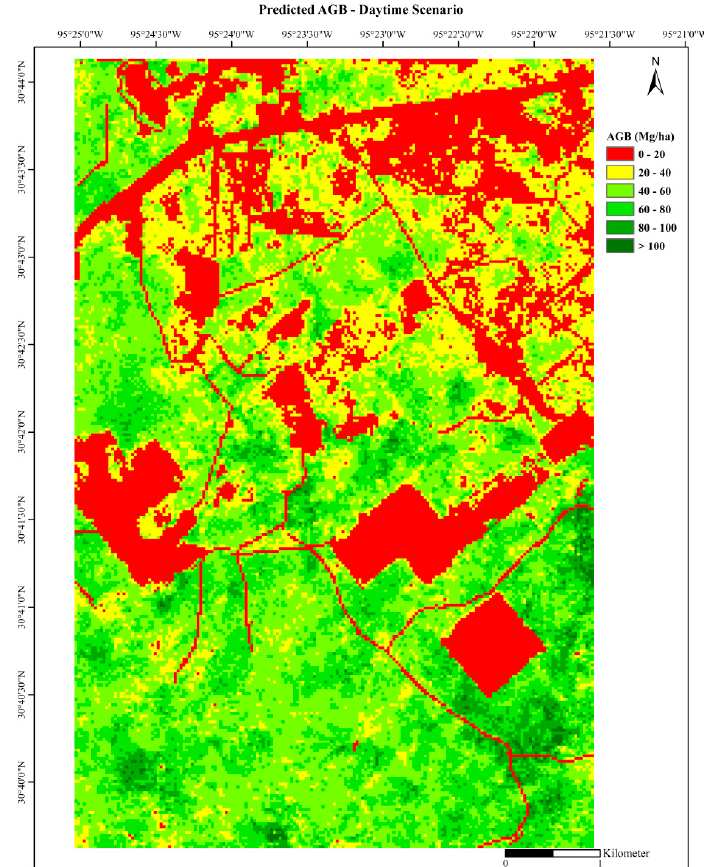
Figure 6. DNN predictions of AGB density at a 30 m spatial resolution for the daytime